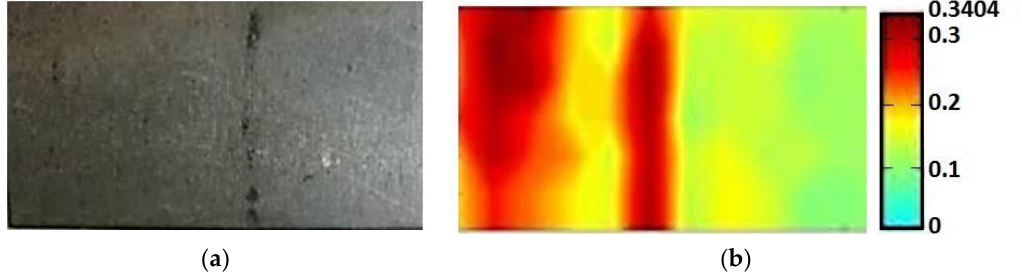
Figure 13. Macrograph around positive segregated bands on the longitudinal section at 30 cm below the hot-top / ingot body interface and the corresponding segregation ratio patterns of carbon: ( a ) Macrograph with black solute-enriched bands; ( b ) mass spectroscopy measurements of the carbon segregation ratio pattern with sampling density of 0.9 × 0.9 cm 2 .